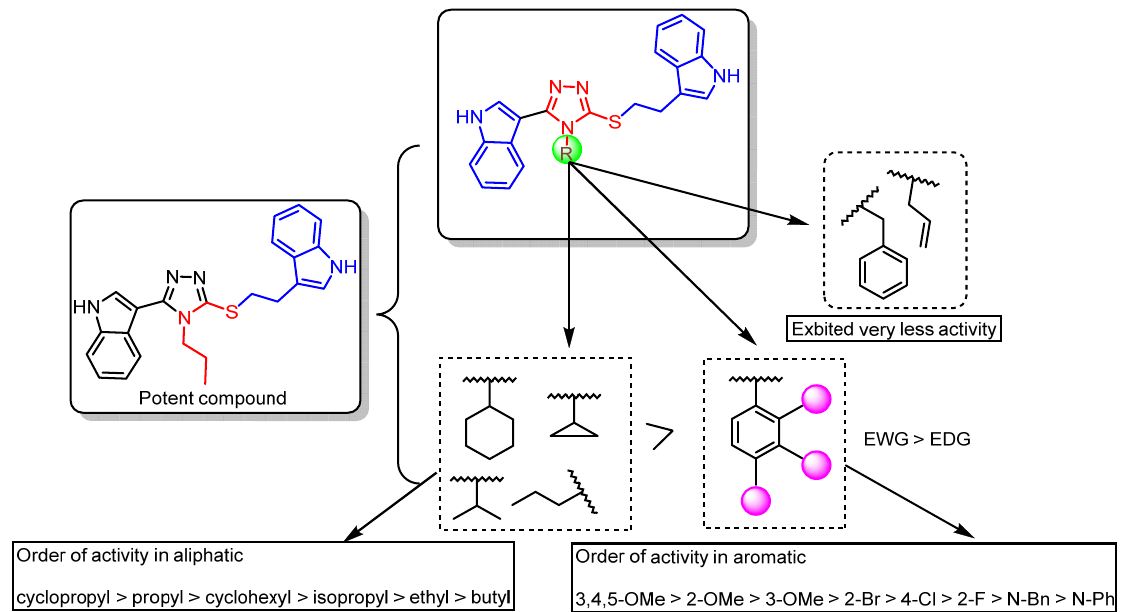
Figure 3. SAR for synthesised compounds against anti-proliferative activity.